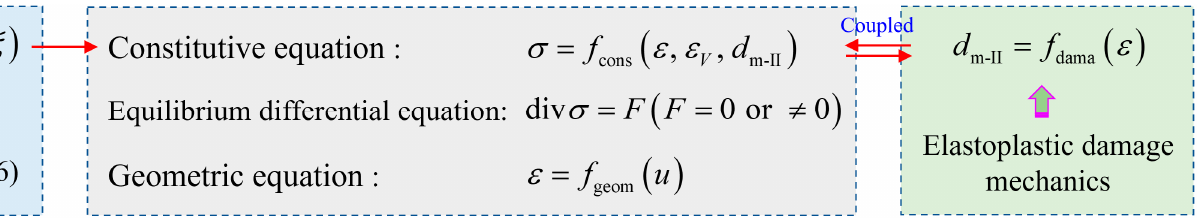
f f f , geom , and dama